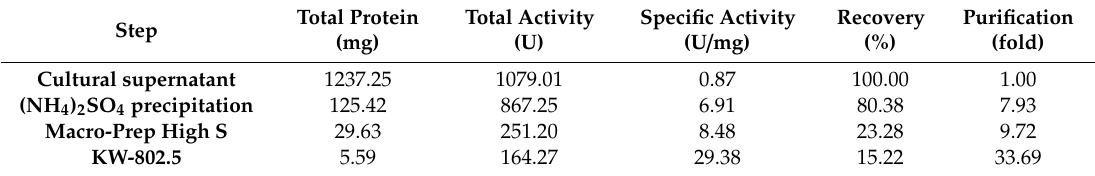
Figure 2. Ion-exchange chromatography profile of the P. mucilaginosus TKU032 crude enzyme on the Macro prep High S column.